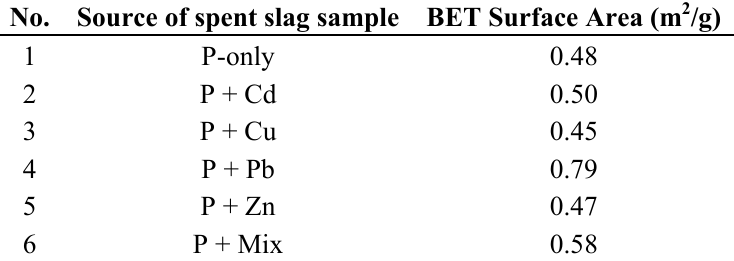
Table 3. BET (Brunauer-Emmett-Teller) Surface Area of spent slag